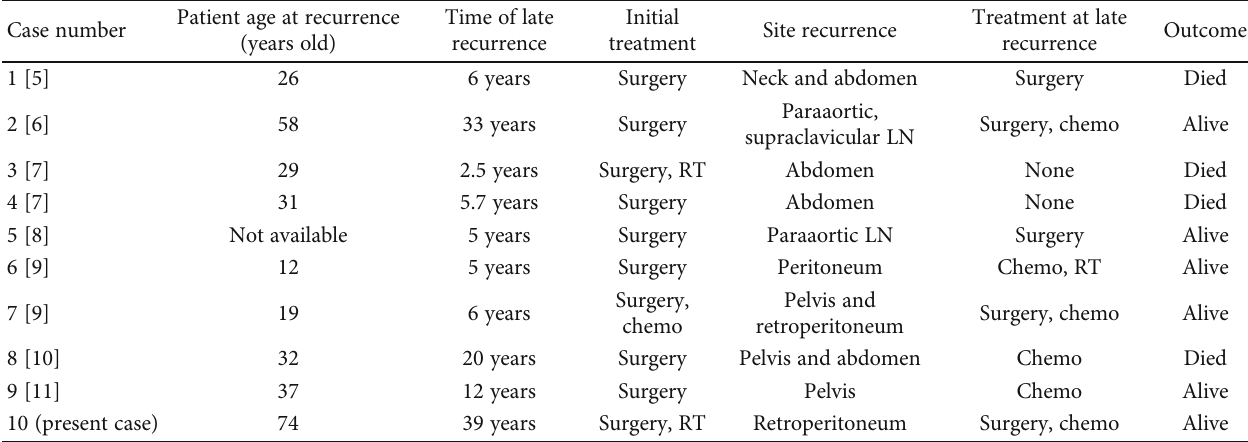
Table 1: Reported and present cases of late recurrence (more than 2 years) in ovarian dysgerminomas. Case